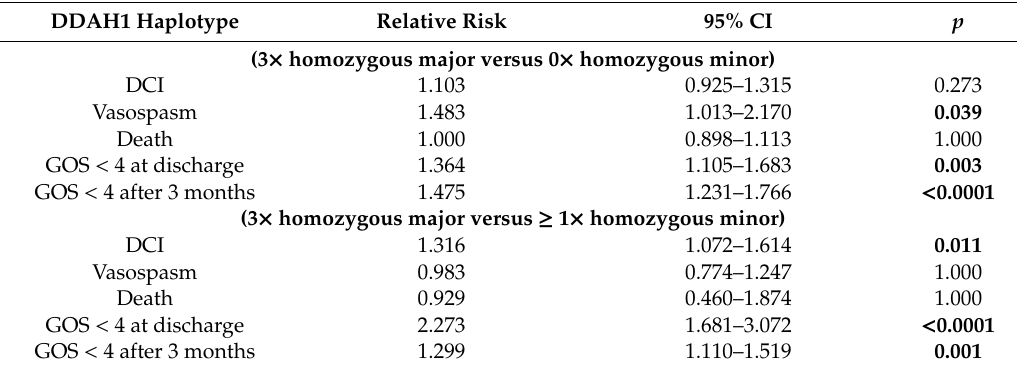
Table 3. Association of the combined DDAH1 haplotype with outcome